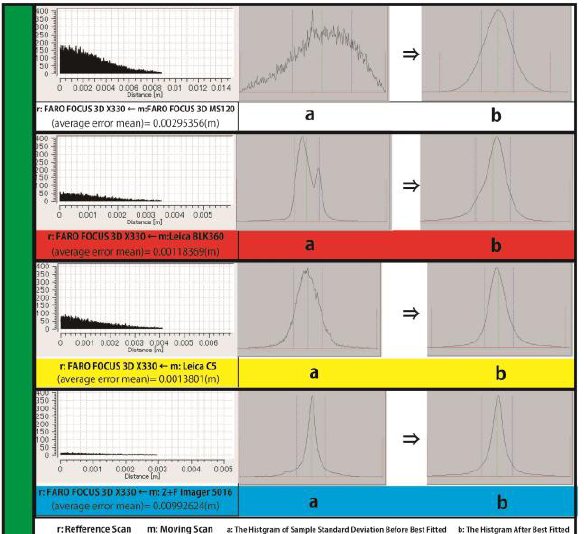
Figure 10: The Results of Aligning (Refference:Leica Scan Station C5), (3D Recnstructor and IMAlign were used)